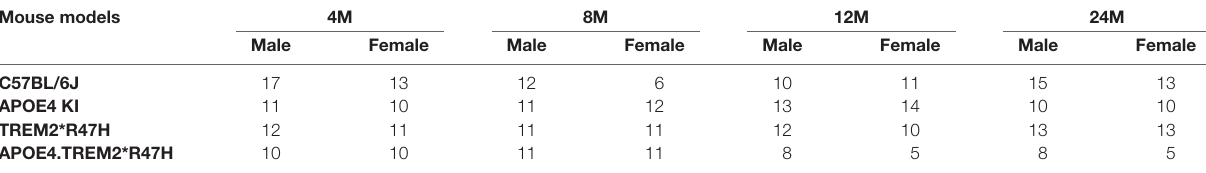
TABLE 4 | Blood and brain tissue cytokine and metabolomic study population. Mouse models 4M